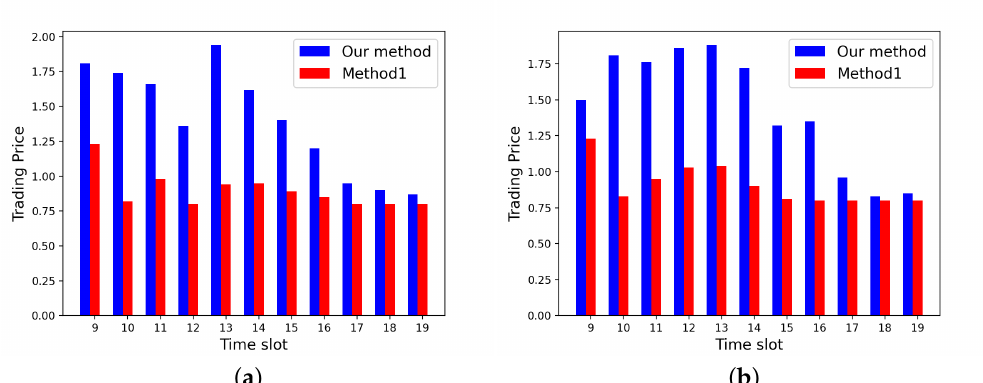
Figure 3. ( a ) Energy trading prices in Building A, ( b ) Energy trading prices in Building B, which are computed by Method 1 and our method throughout the